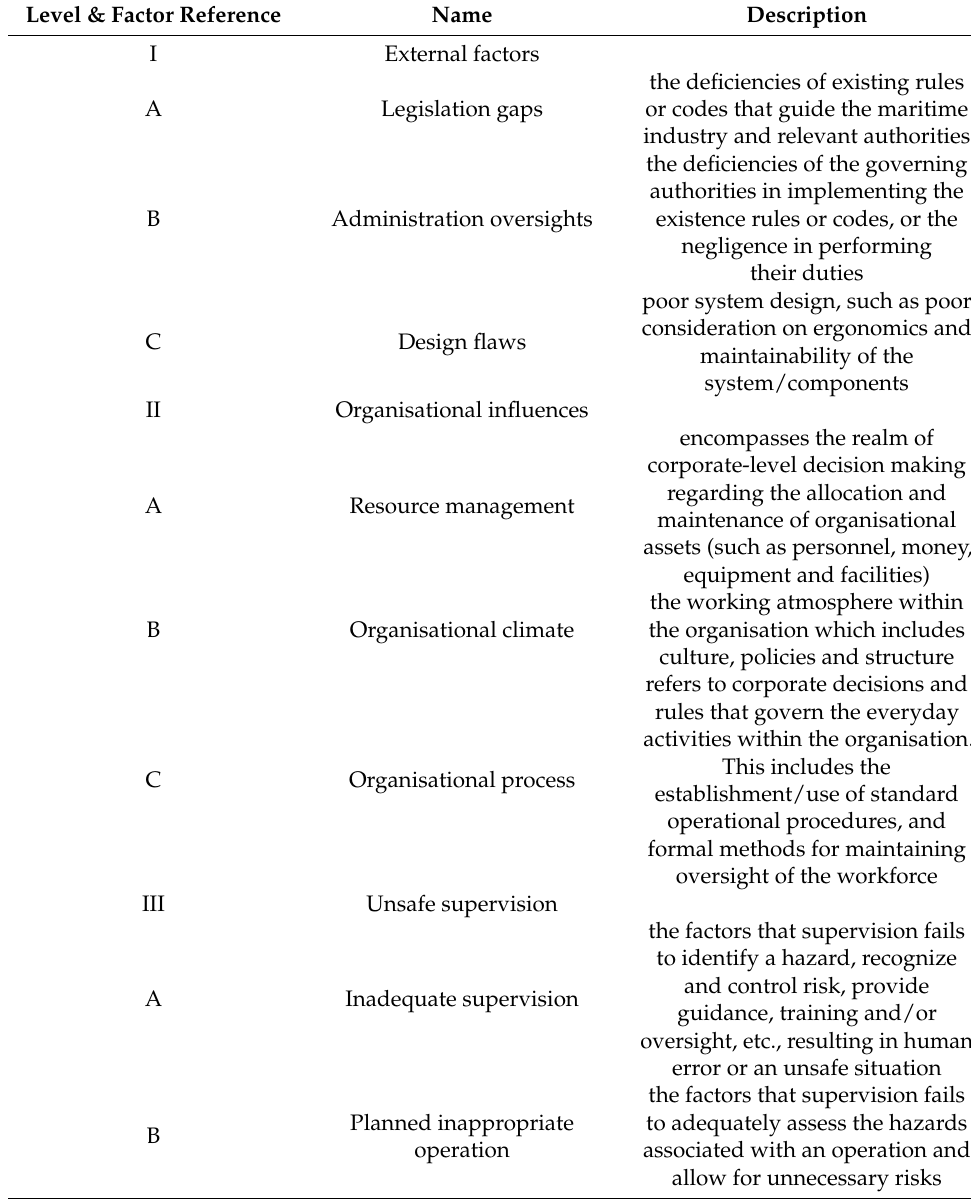
Table 2. Descriptions of causal factor categories within HFACS–MA